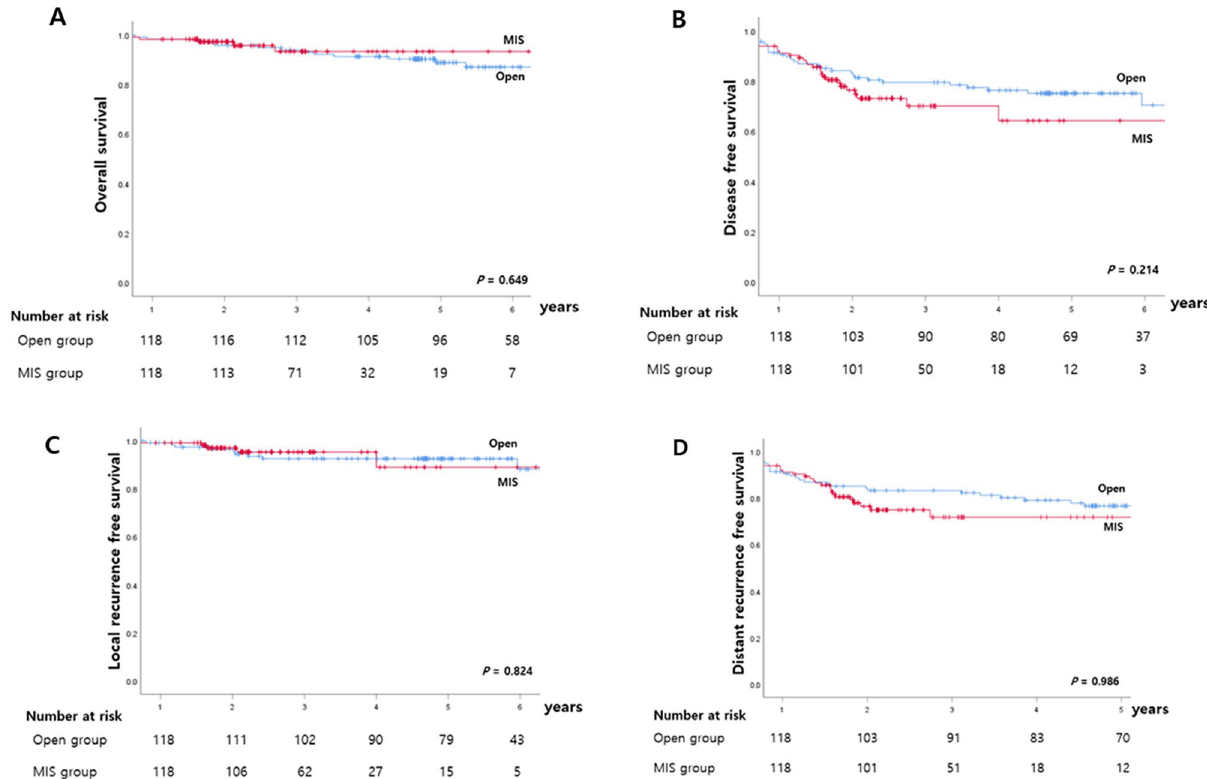
Figure 1. Five-year survival rates according to the operative approach in matched patients. ( A ) Overall survival, ( B ) disease-free survival, ( C ) local recurrence-free survival, ( D) distant recurrence-free